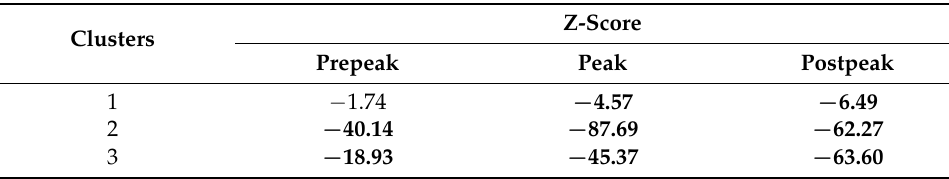
Table 4. The Z-scores of the links of the three clusters. Z-Score Clusters Prepeak